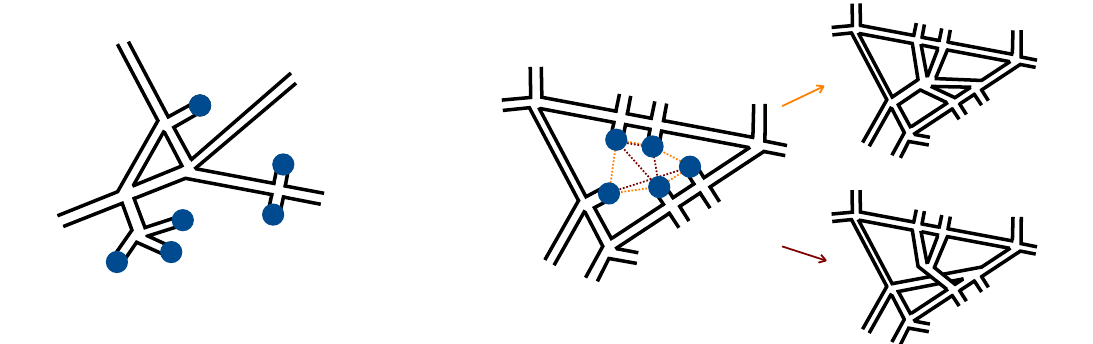
H q (left), the Figure 4: Ribbon graph of quartic matrix model with coupling Tr p H 0 insertions of the external field H (blue dots) are like leaves on a tree. For the gravity 0 interpretation one must perform the unitary integral (right), giving a double sum over Wick contractions or permutations of which we show two examples (orange and red). The new vertices are weighed by Weingarten functions and traces of H , 0 because of the Weingarten functions the orange contraction dominates for large L , as explained in detail in section